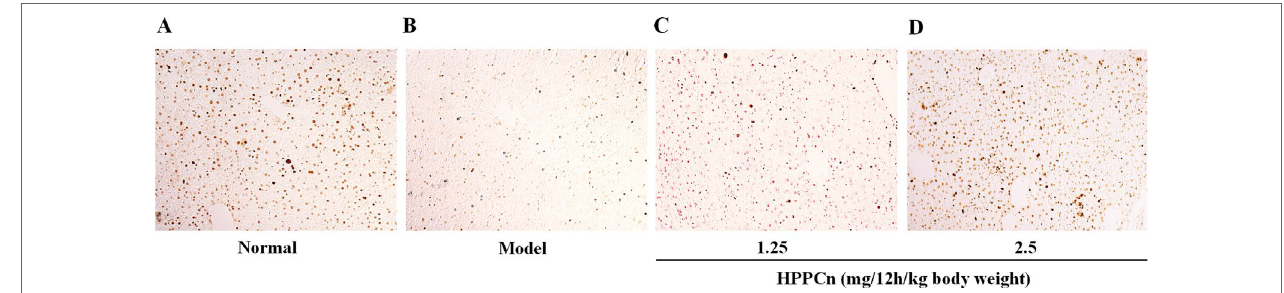
FIGURE 7 | rhHPPCn promoted hepatocyte proliferation in CCl 4 -induced acute liver injury model mice. PCNA expression was detected by immunohistochemistry after acute injured liver treated with different concentrations of rhHPPCn. (A) Control normal mice. (B) Acute liver injury model mice. (C) Acute liver injury model mice treated by rhHPPCn at 1.25 mg/12 h/kg body weight for 24 h. (D) Acute liver injury model mice treated by rhHPPCn at 2.5 mg/1 2h/kg body weight for 24